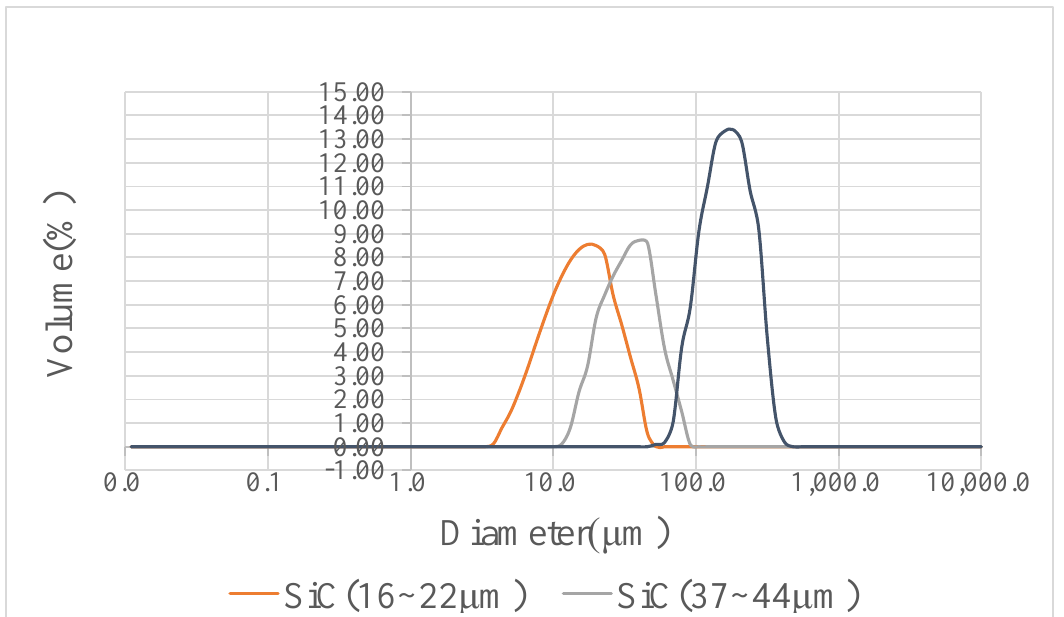
Figure 2. Size distribution of particles used in this study.